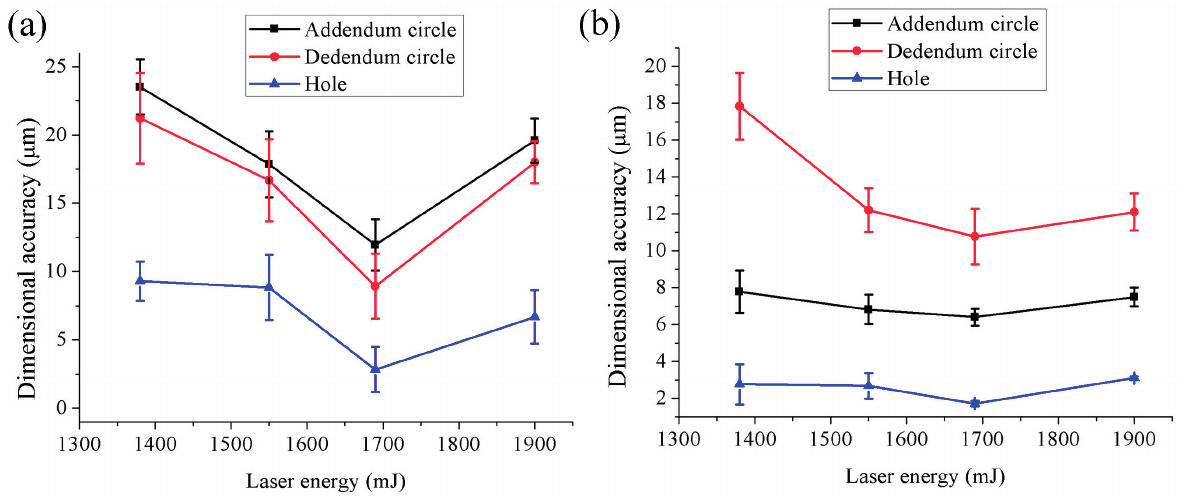
Figure 3. Effect of the laser energy on quality of micro-gears: ( a ) punched by lighter blank-holder and ( b ) heavier blank-holder. Error bar: Standard deviation.